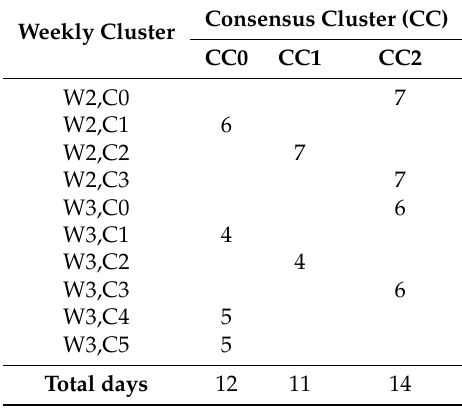
Table 4. Number of identified daily deviating behaviours in weeks 2 and 3 for building B_3 in 2017. Weekly